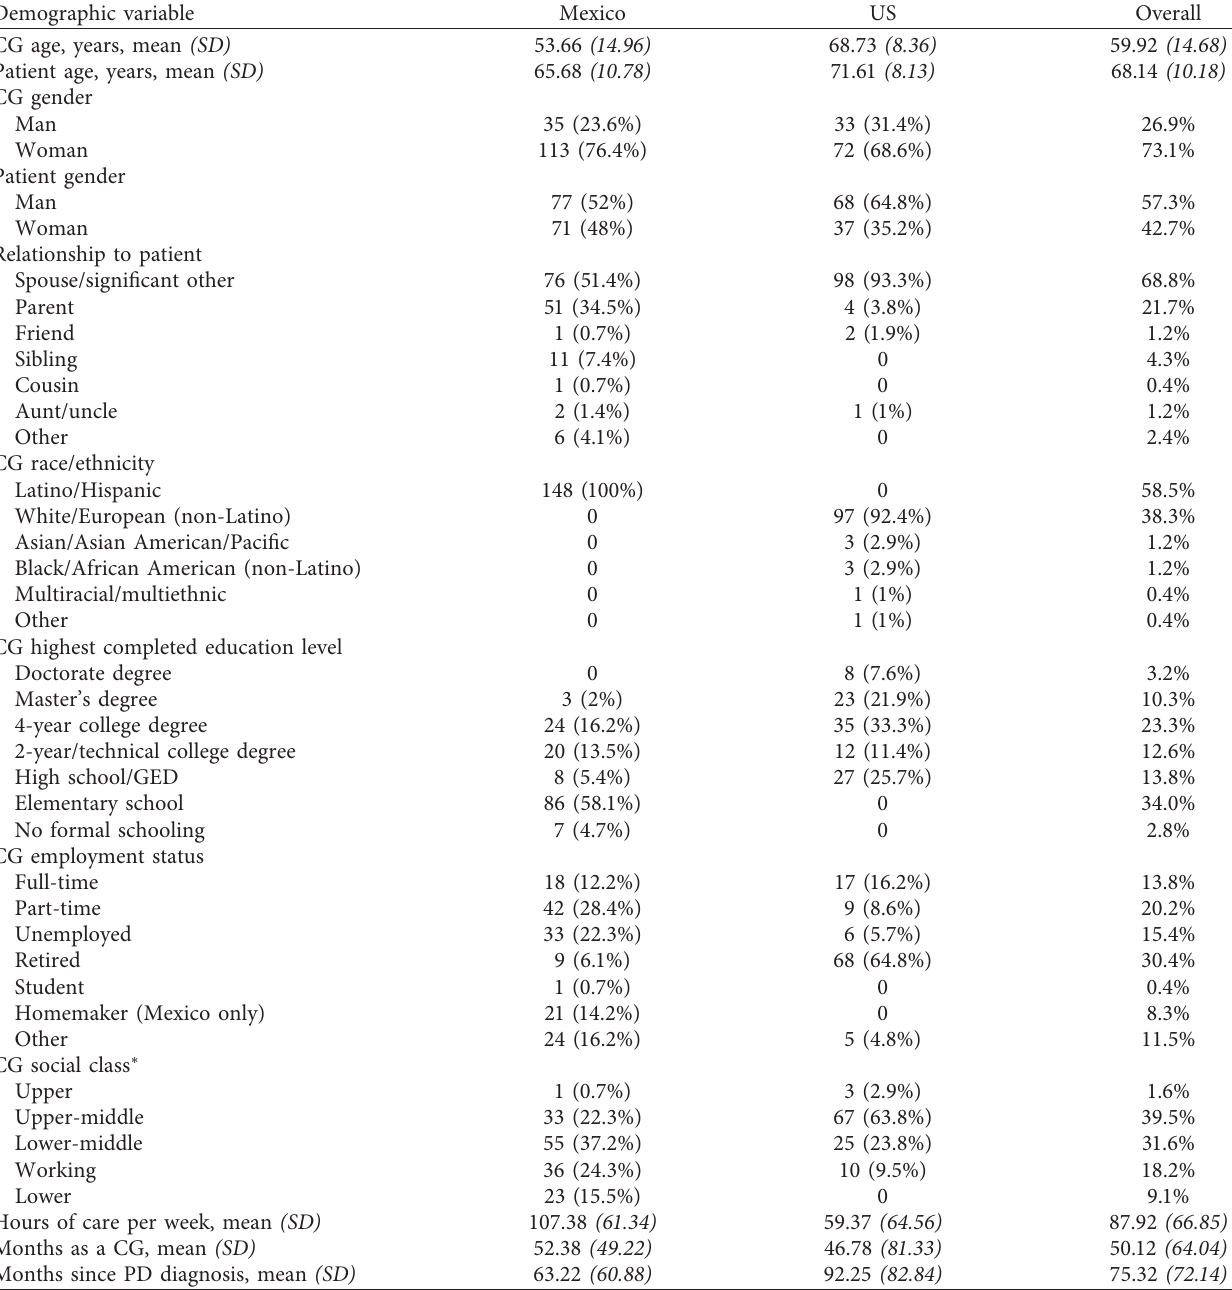
Table 1: Characteristics of PD caregivers and